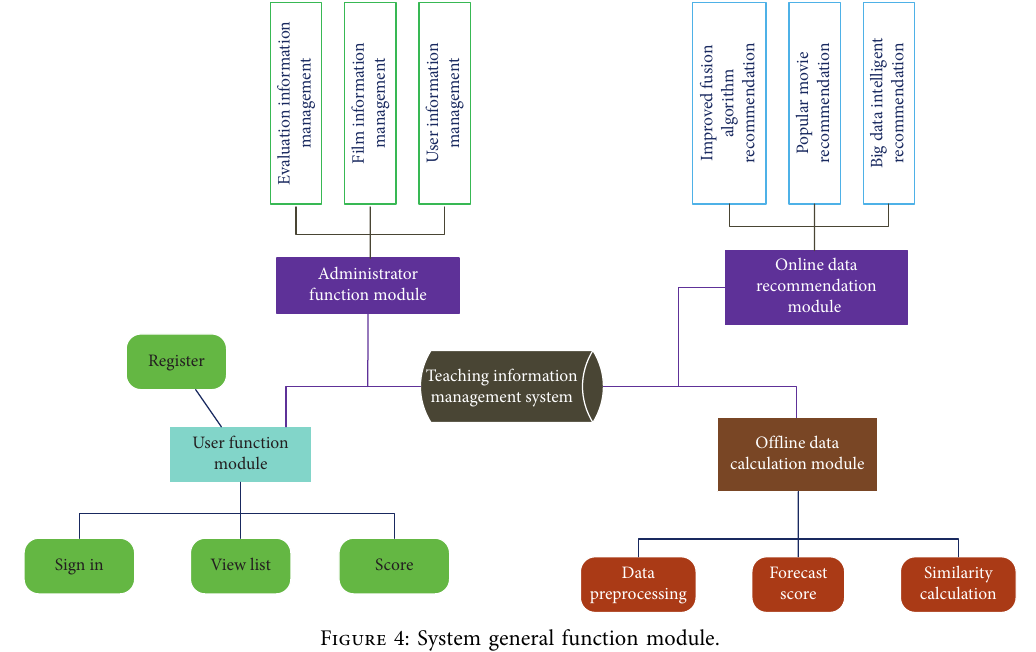
Figure 4: System general function module.